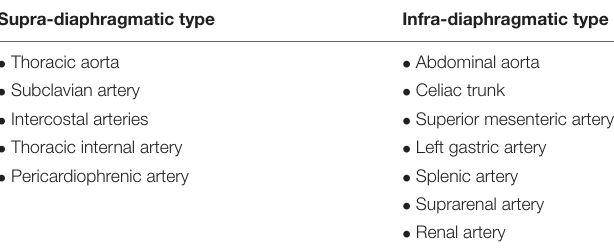
FIGURE 2 | Thoracic contrast-enhanced computed tomography scan (CECT) showing infra-diaphragmatic arterial and venous systemic connection of left inferior extralobar bronchopulmonary sequestration: arterial supply originates from the abdominal aorta (red arrow), venous drainage via portal vein (blue